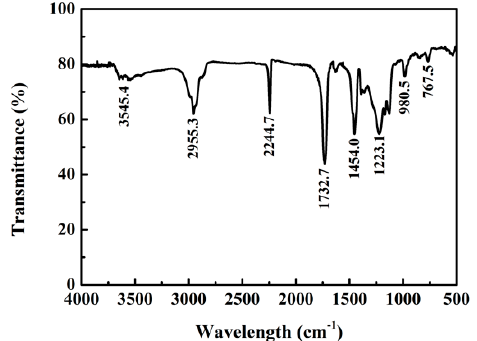
Figure 2. IR spectra of microspheres.